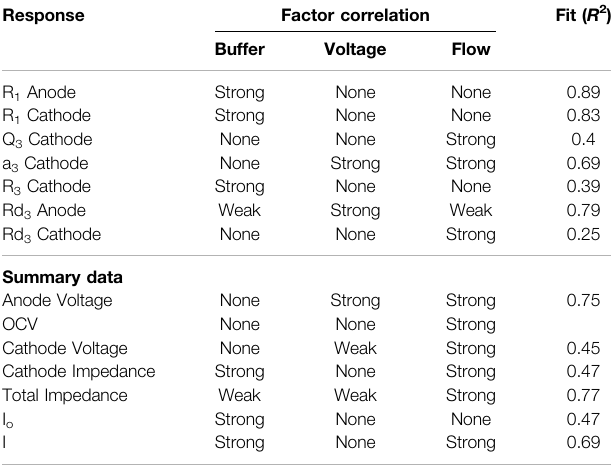
TABLE 3 | Strength of correlation (based on p values) and the R 2 values for correlations between investigational parameters and response variables.